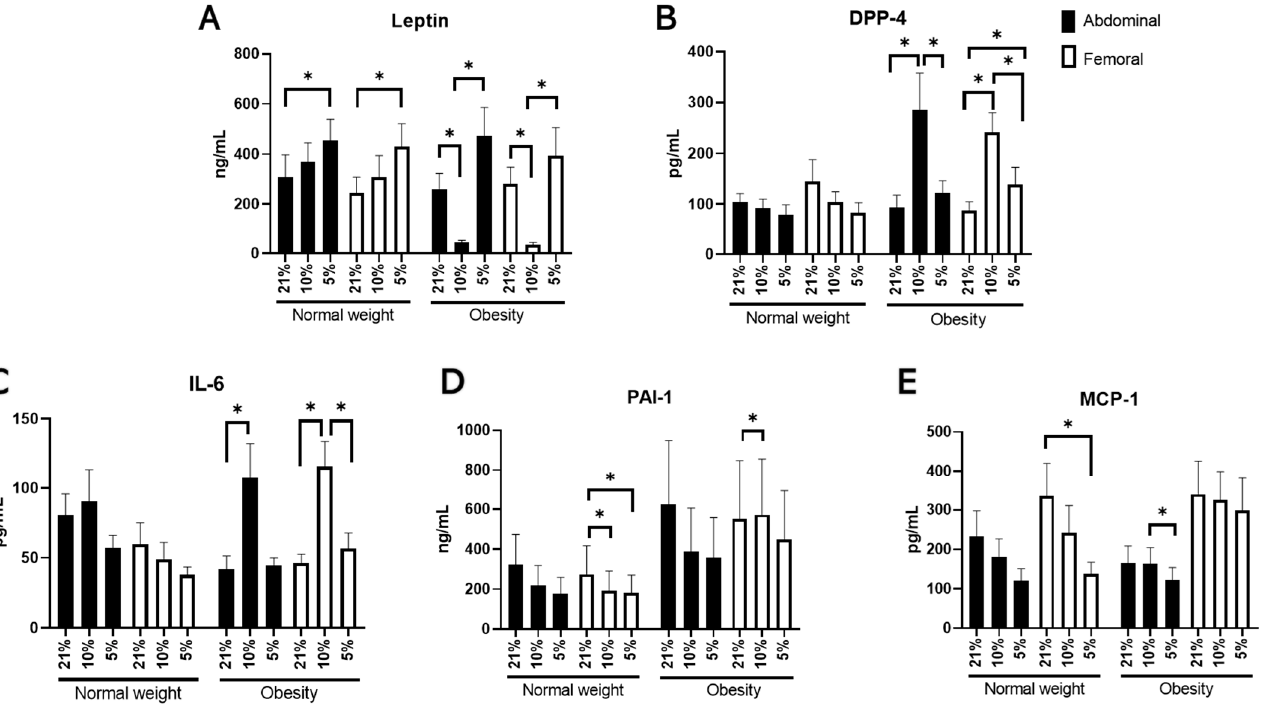
Figure 2. Adipokine and inflammatory markers’ secretion in hMADS cells following differentiation under different pO 2 s (21% vs. 10% vs. 5% O 2 ) ( n = 9 paired samples). ( A ) Leptin, ( B ) dipeptidyl- peptidase (DPP)-4, ( C ) interleukin (IL)-6, ( D ) plasminogen activator inhibitor (PAI)-1, and ( E ) mon- ocyte chemoattractant protein (MCP)-1. Data are expressed as mean ± SEM. * p < 0.05.